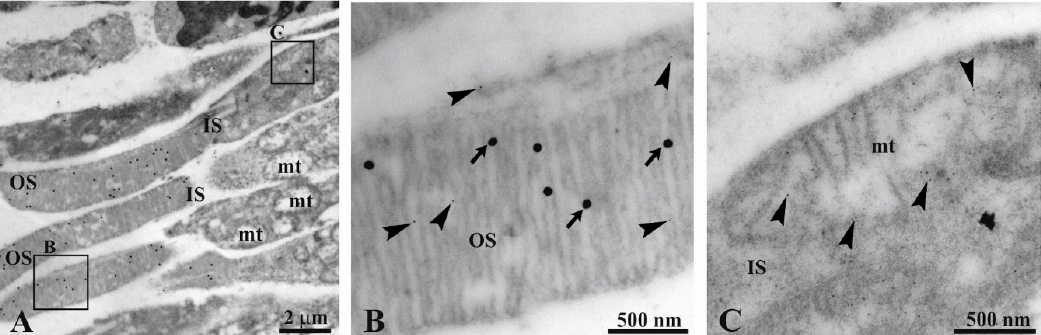
Figure 1. Immunogold experiment with transmission electron microscopy (TEM) on bovine retina. ( A ) Retina section showing inner (IS) and outer (OS) photoreceptor segments. ( B , C ) Enlargements corresponding to the squared areas B, C in Panel A, to show a detail of an OS and mitochondrion. Largest gold particles (40 nm width, arrows) reveal Ab against anti ‐ rhodopsin in OS. The smallest gold particle (10 nm width, arrowhead) reveals Ab against anti ‐ ATP synthase β‐ subunit in both OS and a mitochondrion.